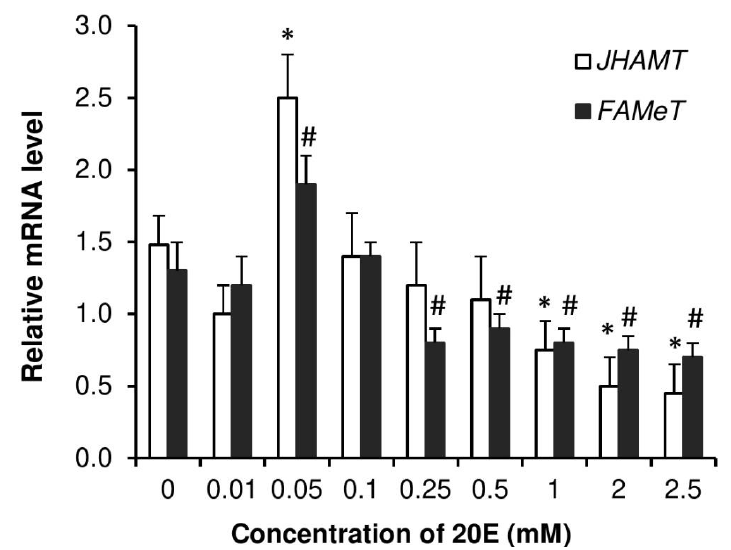
Figure 8. Dose response for induction by 20E. Expression of JHAMT and FAMeT in the brain of adult P. americana females 4 days after injection with 10 µL of the different given concentrations of 20E. Control roaches were injected with 10 µ L of ca. 0.1% EtOH solvent. Data are presented as mean ± SEM. Columns with symbols (*: JHAMT ; #: FAMeT ) are significantly different at p < 0.05, compared to 0 concentration, using Tukey’s test. Insects 2020 , 11 , x